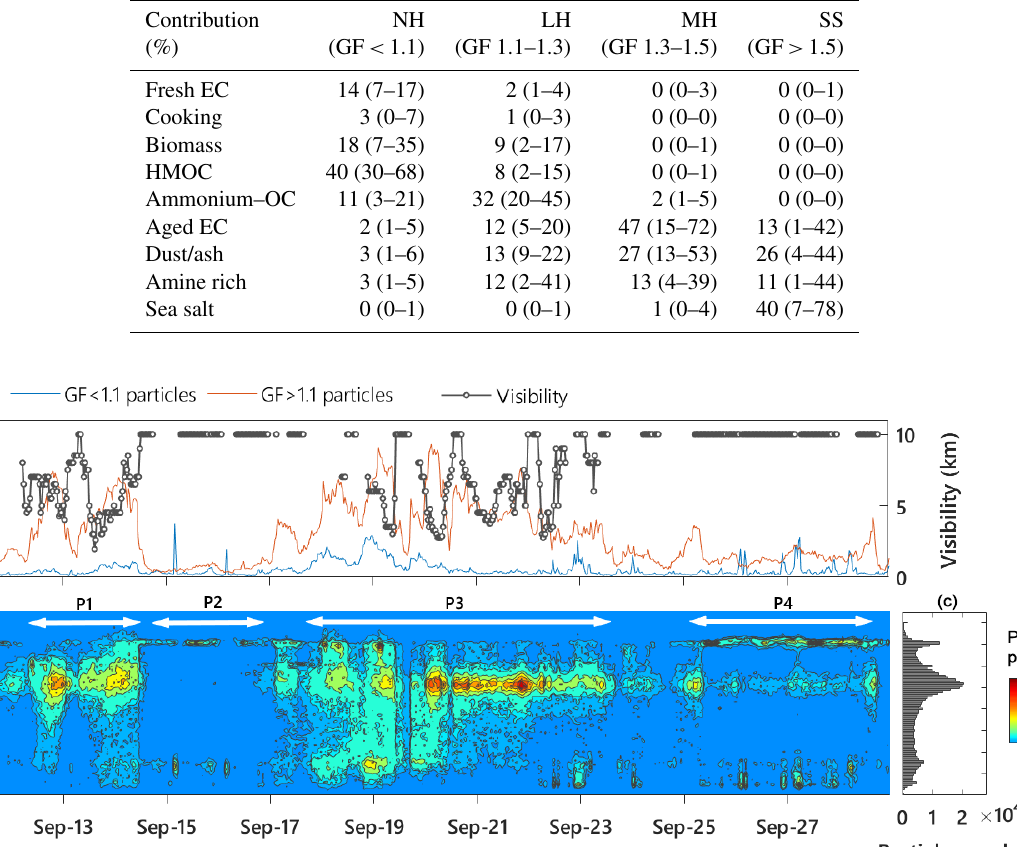
Figure 8. Temporal variations in atmospheric visibility and number concentrations of nearly hydrophobic (estimated GF < 1.1) and hy- groscopic (GF > 1.1) particles (a) . (b) The temporal variation in estimated GF from 12 to 28 September 2012. (c) The particle number distribution with GF during the